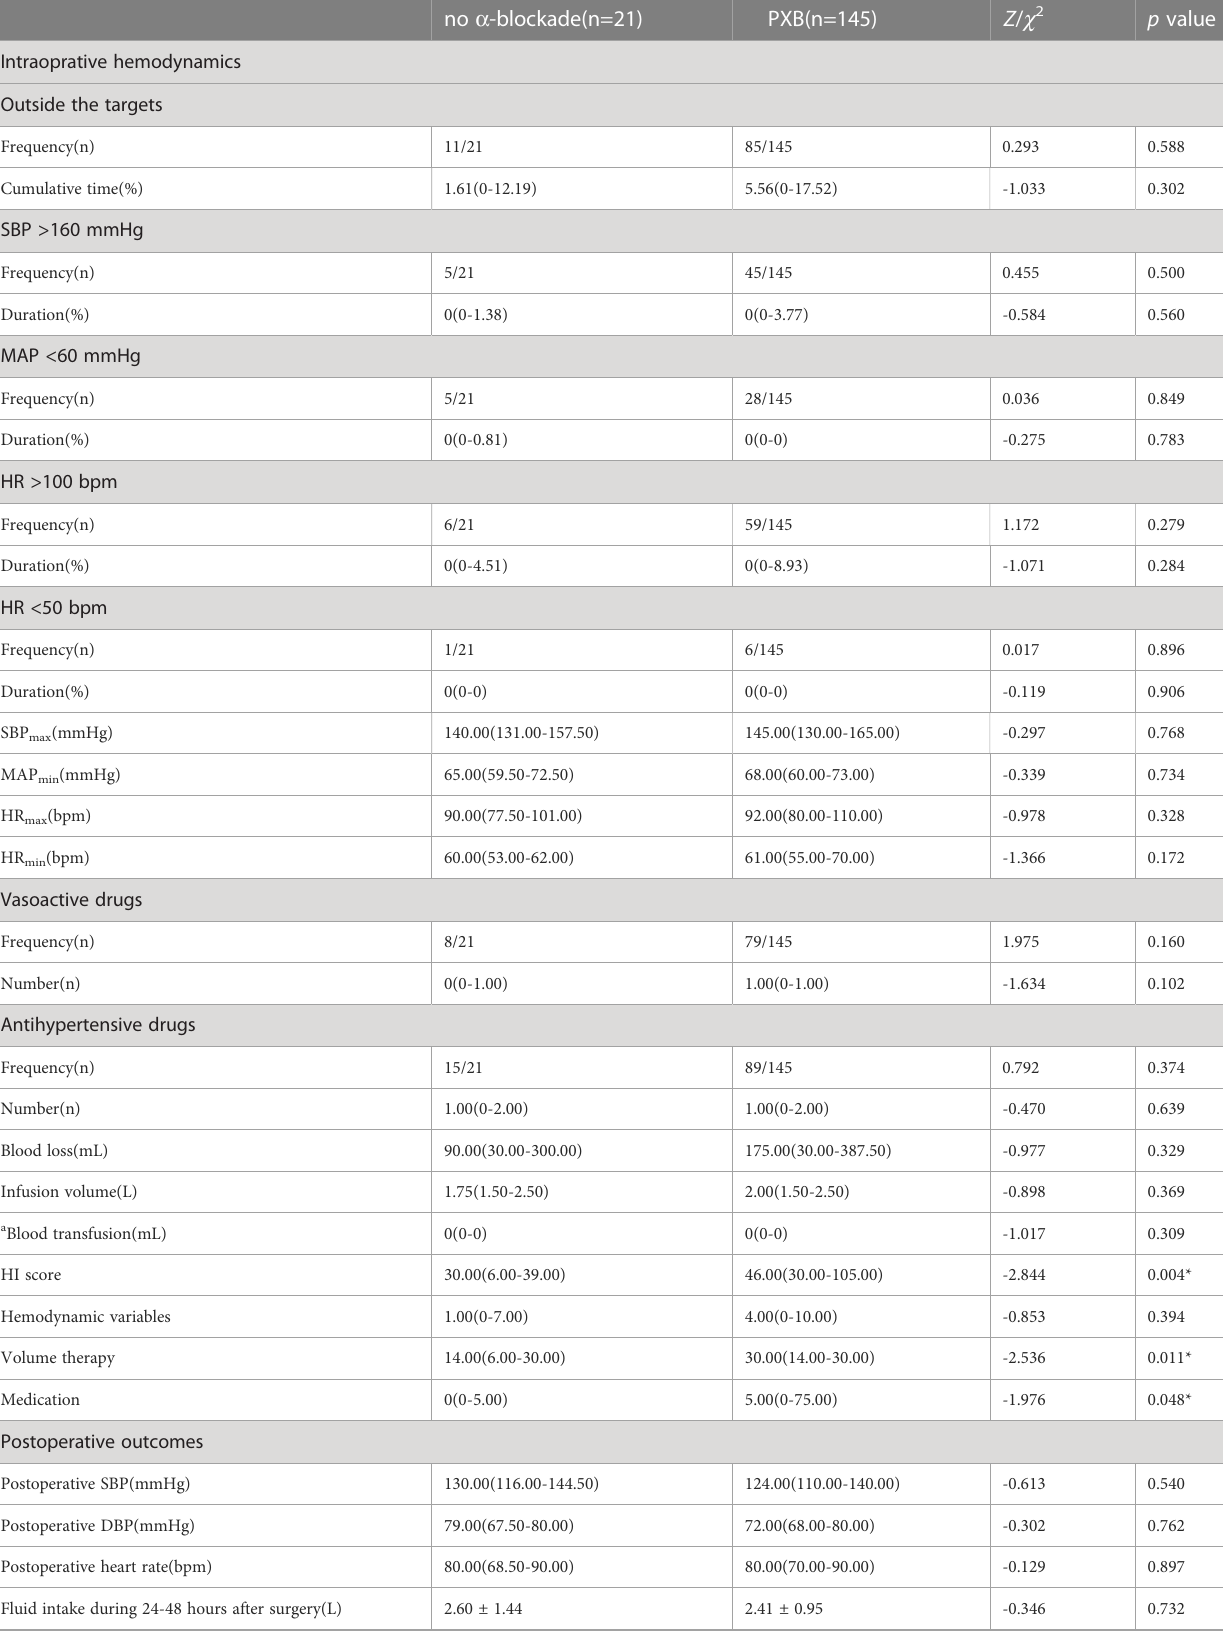
TABLE 5 The effect of a -blockade on perioperative hemodynamics of patients with